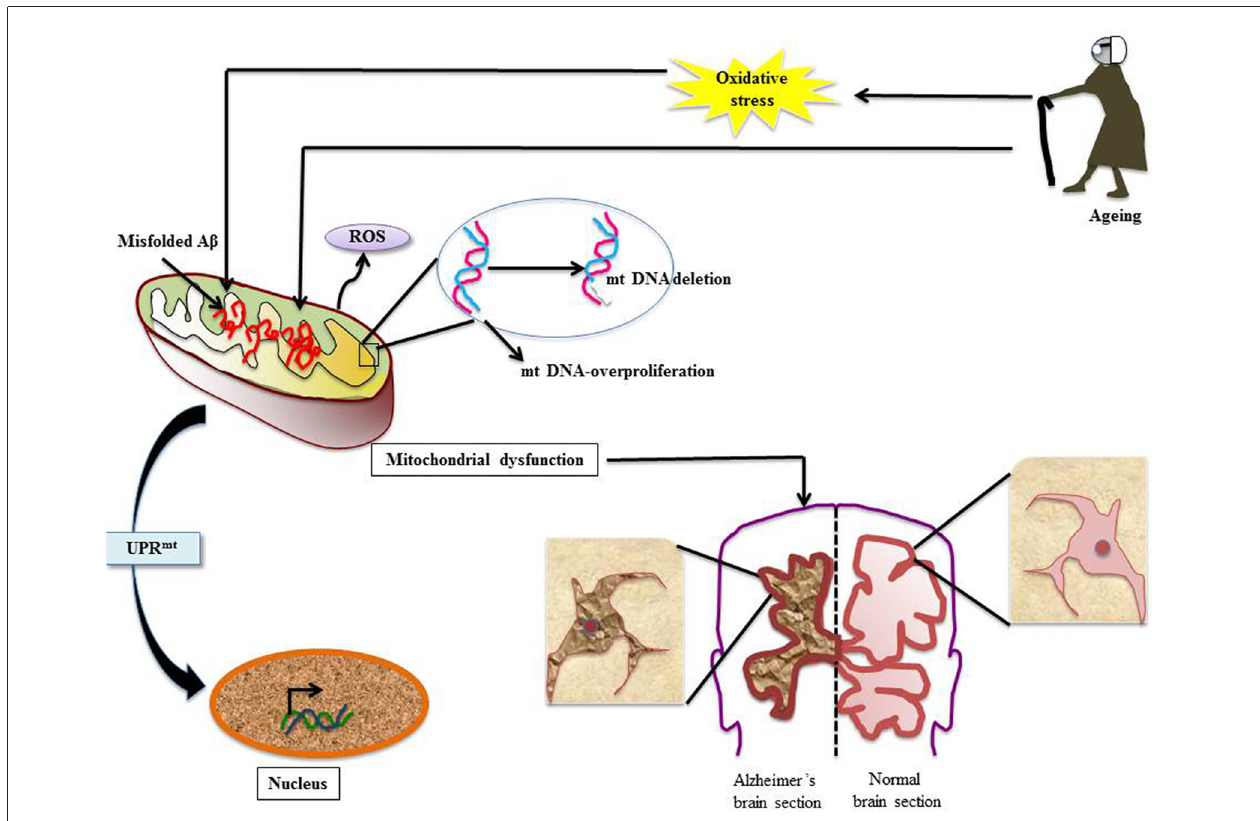
FIGURE 2 | Mitochondrial dysfunction in AD: various stress insults like aging and oxidative stress disrupt client protein folding in mitochondria thereby invoking mitochondrial UPR (UPR mt ). Numerous events line up; there is mitochondrial DNA (mtDNA) proliferation and deletion, misfolded A β overload and ROS generation. This leads to the condition of mitochondrial dysfunction and to rescue the ailing cell UPR mt is stimulated. The effect of mitochondrial dysfunction leads to development of neuropathologies associated with AD (Aliev et al., 2008, 2013; Onyango et al.,